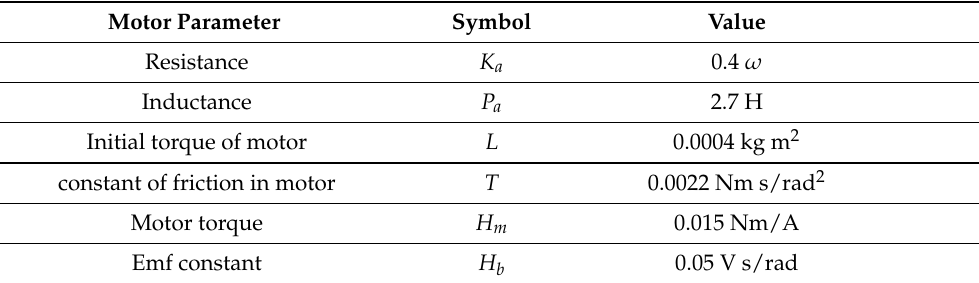
Table 12. Various parameters of DC motors.